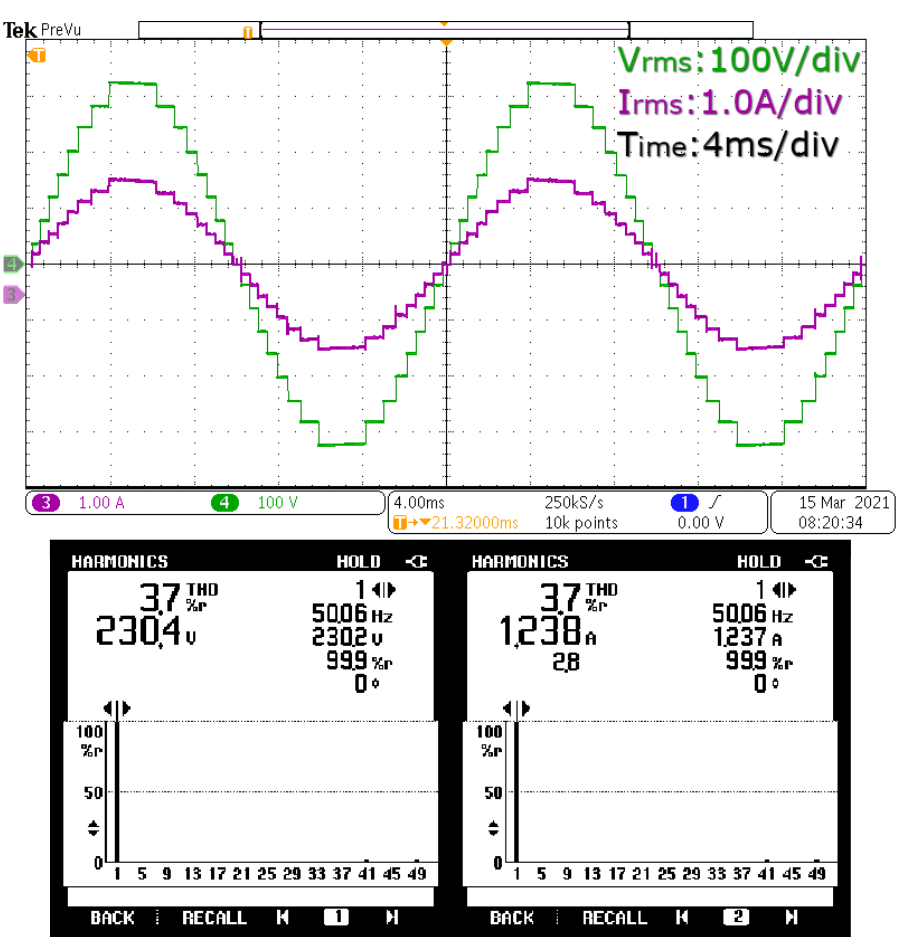
Figure 17. Experimental output waveforms and THD analysis under incandescent light bulb load.